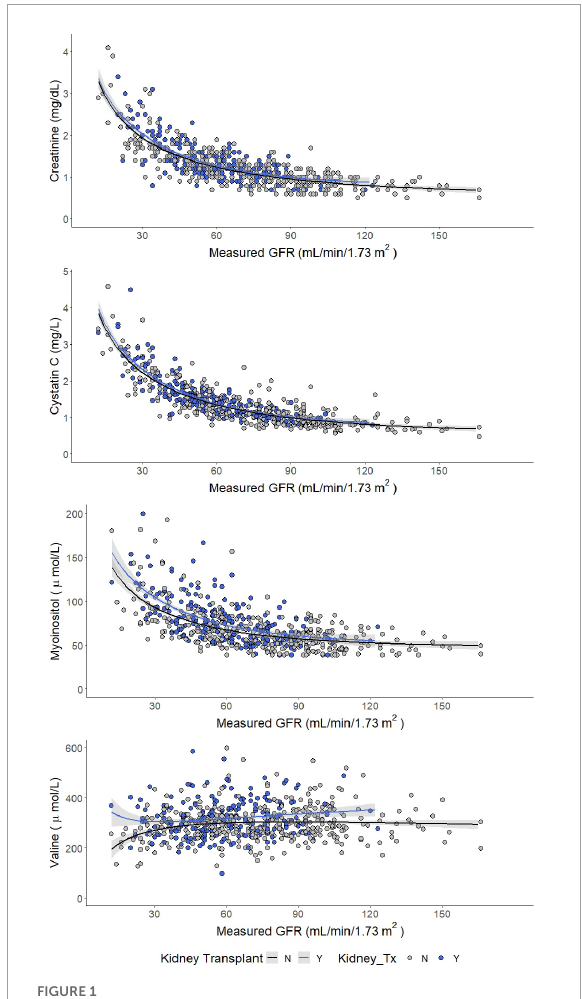
FIGURE1 Concentrations of creatinine (enzymatic), cystatin C, myo-inositol, and valine as a function of measured